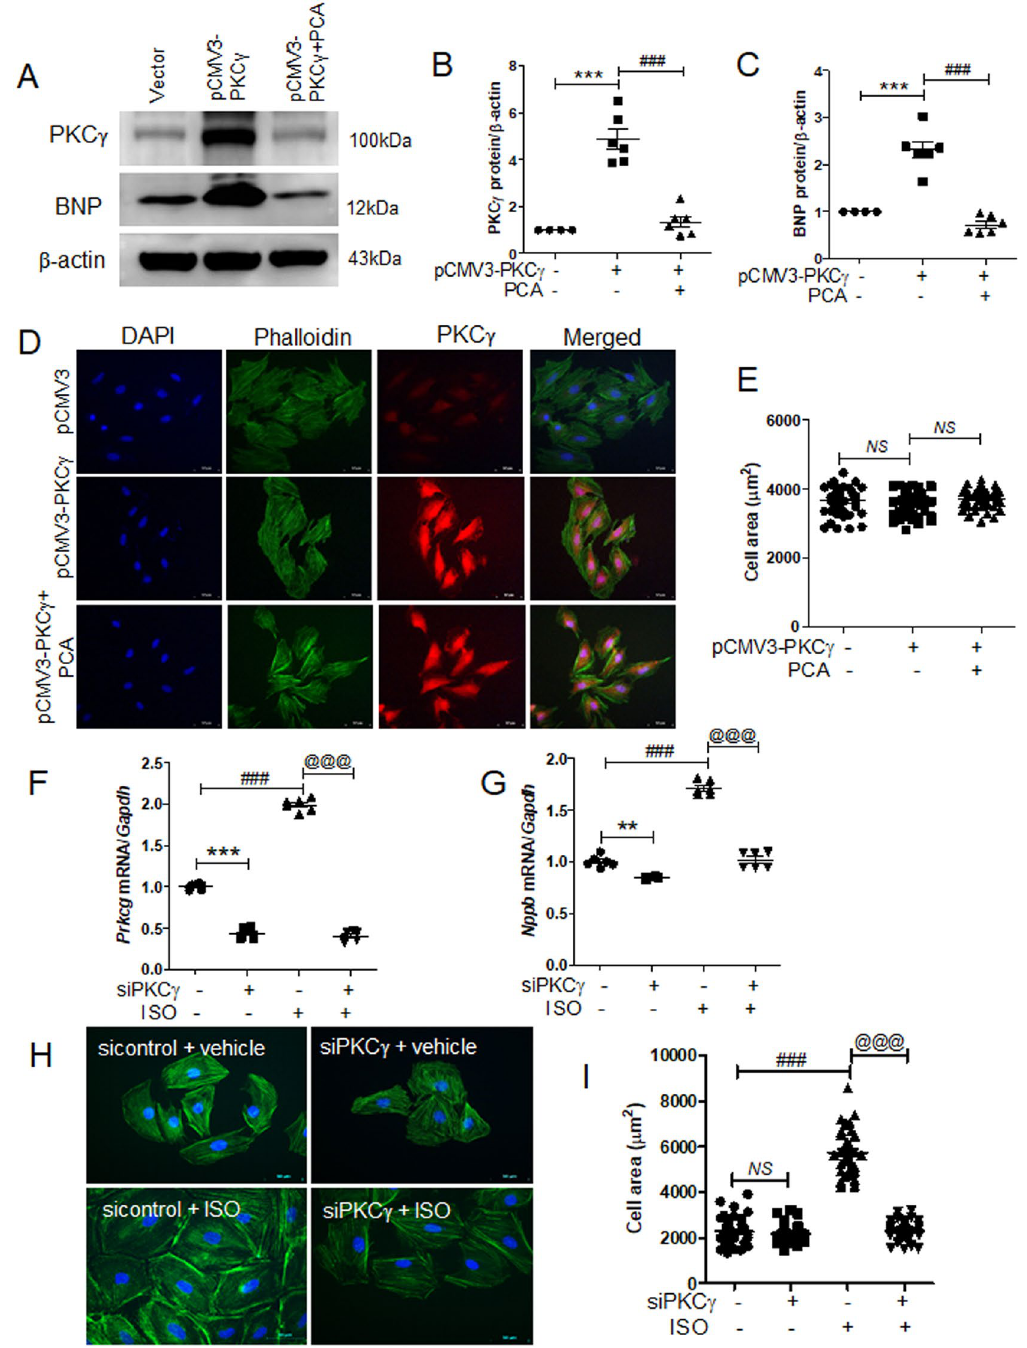
Figure 7. PKCγ knockdown reduces isoproterenol-induced cardiac hypertrophy in H9c2 cells. ( A ‒ E ) H9c2 cells were transfected with empty vector or pCMV3-N-GFPSpark-PKCγ and then treated with protocatechuic acid (10 μM). ( A ) Representative western blot images showing PKCγ and BNP protein levels in pCMV3-N-GFPSpark-PKCγ -transfected cells. β-actin was used as a loading control. ( B , C ) Quantification of PKCγ and BNP protein levels (n = 6). ***P < 0.001; ### P < 0.001. ( D , E ) Representative images of cells transfected with pCMV3-N vector or pCMV3-N-GFPSpark-PKCγ , incubated with or without protocatechuic acid (10 μM), and then stained with anti-PKCγ antibody, Alexa Fluor 488 phalloidin, and DAPI. PKCγ-positive cells (red); nuclei (blue); actin filaments (green). Scale bar = 50 μm. ( F , G ) H9c2 cells were transfected with control or PKCγ siRNA, serum starved overnight, and then treated with isoproterenol (10 μM). The mRNA levels of Prkcg and Nppb were determined by RT-PCR (n = 6). **P < 0.01 and ***P < 0.001; ### P < 0.001; @@@ P < 0.001. ( I ) Merged images of H9c2 cells transfected with PKCγ siRNA, incubated with or without isoproterenol (10 μM) for 24 h, and then stained with Alexa Fluor 488 phalloidin (green) and DAPI (blue). ( J ) Cell size was quantified by measuring the cell surface area of Alexa Fluor 488 phalloidin-stained cells (n = 40 cells). Scale bar = 50 μm. ### P < 0.001; @@@ P < 0.001; NS not significant. Data are presented as the mean ± S.E. Statistical analysis: one- way ANOVA followed by Bonferroni post hoc tests. Graphs were prepared using GraphPad